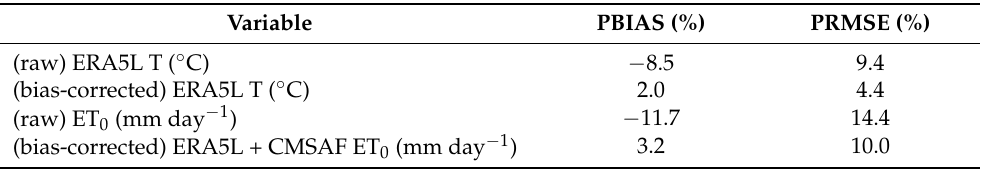
Table 6. Performance of the ERA5L temperature and reference evapotranspiration computed from the merged ERA5-Land and CM-SAF database for 2021 at the study